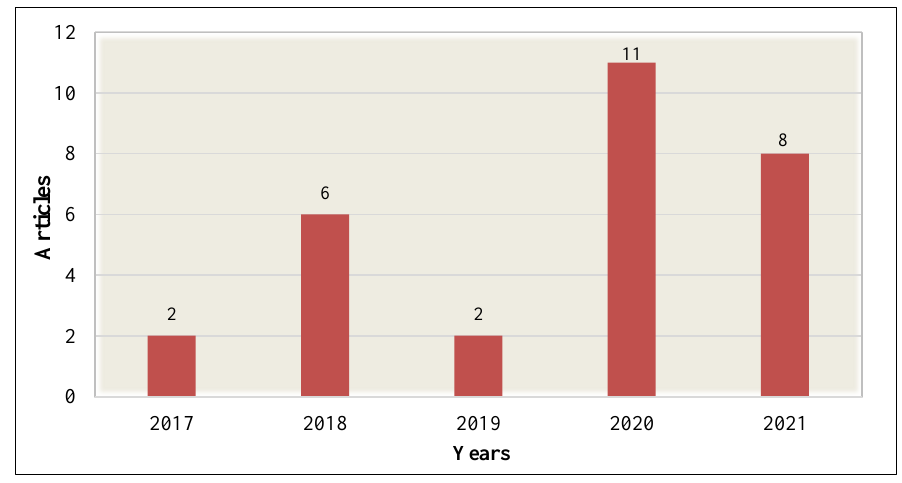
Figure 2. Production by year: